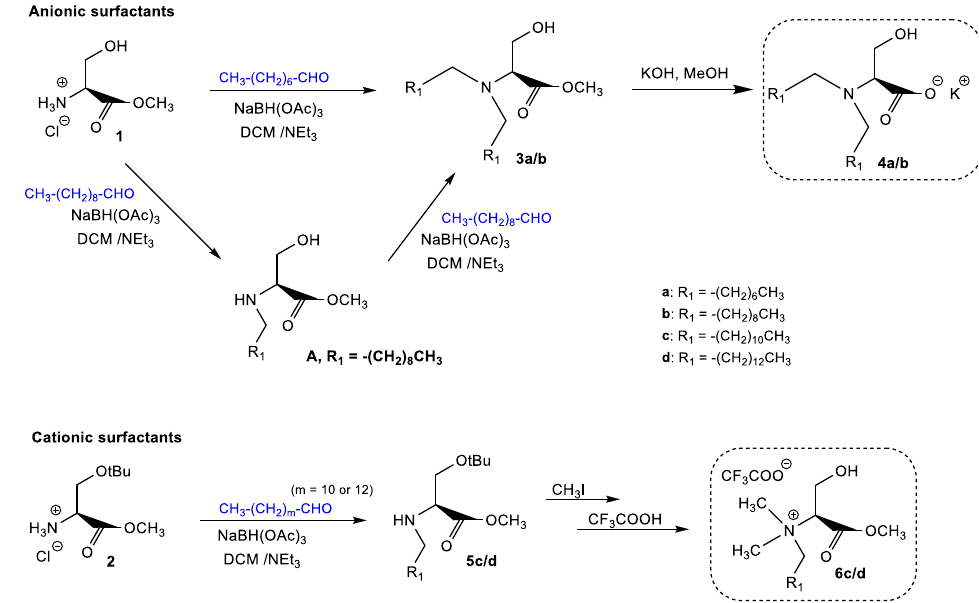
Scheme 1. Synthetic routes for the serine-based